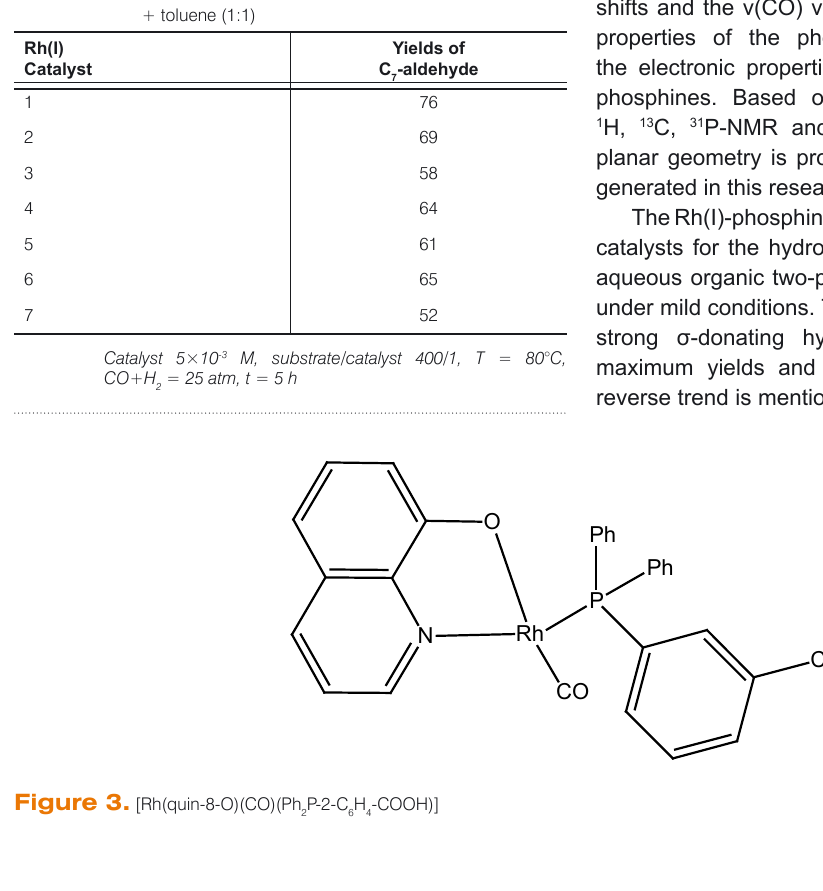
Table 4. Catalytic Hydroformylation of cyclohexene in water